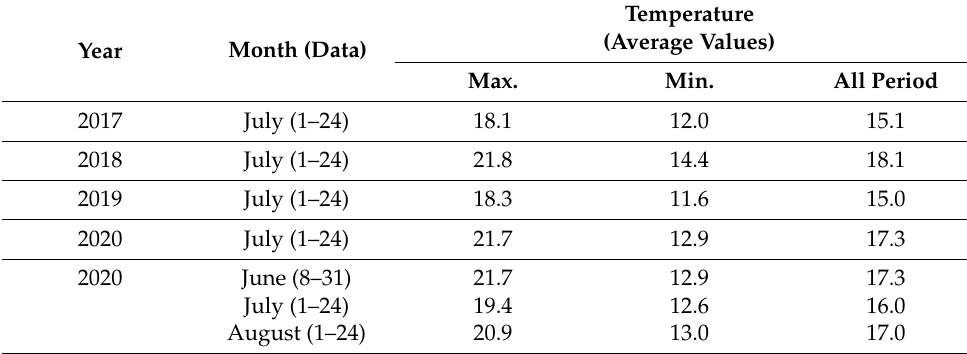
Table 1. The characteristics of the air temperatures during the research period.